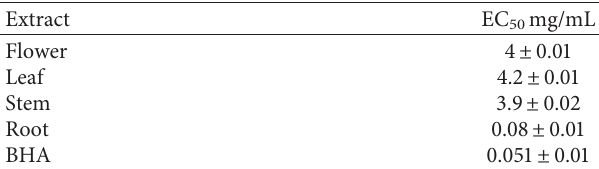
50 mg/mL of organ